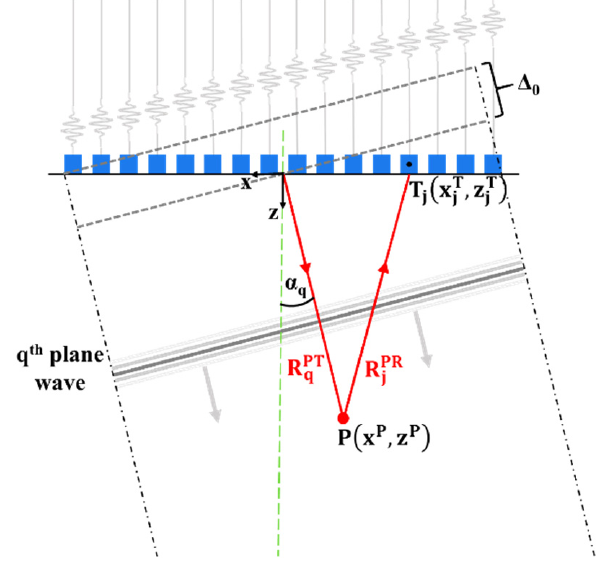
Figure 1. The conceptual outline of classic 2D PWI method. 𝑅 (cid:3044)(cid:3017)(cid:3021) is the q th incident plane wave travel path to the focus point P, 𝑅 (cid:3037)(cid:3017)(cid:3019) is the travel path on reception from P to j th array element T j , angle 𝛼 (cid:3044) is the plane wave angle and Δ (cid:2868) is the correction factor offsetting the excitation to begin at t = 0. The main difference between the 2D PWI and its pipe implementation is that the pipe wall is a closed geometry. The waves on transmission and reception travel around the pipe in helical paths as presented in Figure 2.